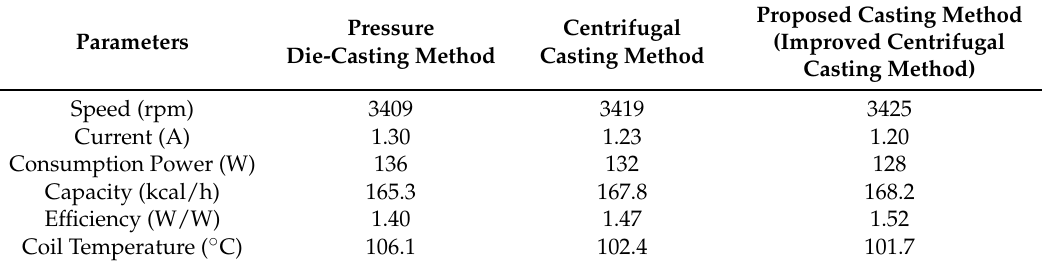
Table 9. The results of applying to stator #2 (115 V/60